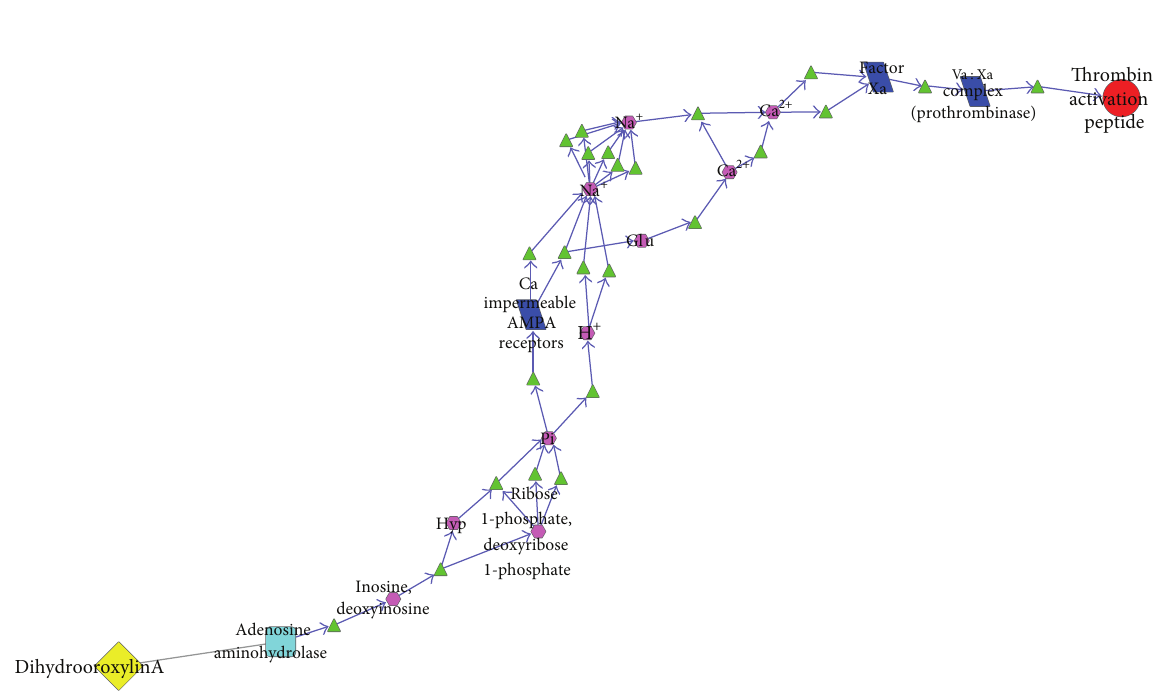
Figure 7: The antipneumonia biological pathway of dihydrooroxylin